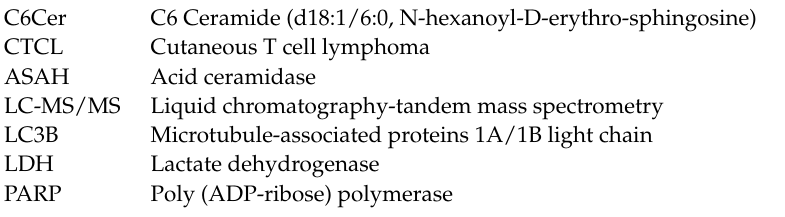
Figure S3: Western Blots of Figure 4A, Figure S4: Western Blots of Figure